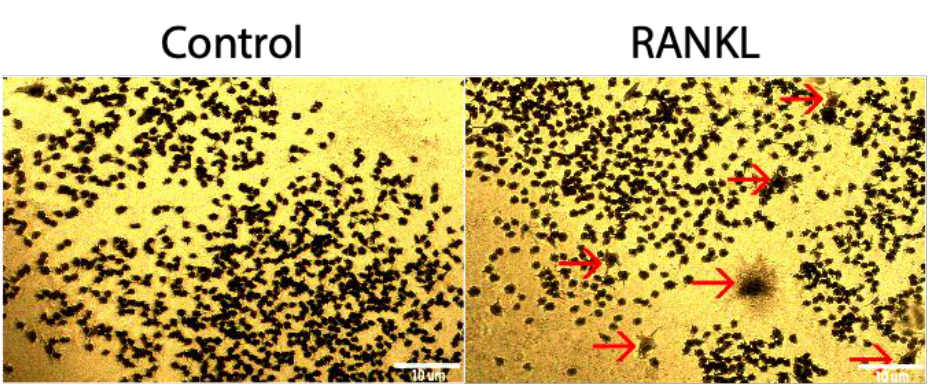
Figure 3. TRAP assay of RAW264.7 cells stimulated with RANKL. After 5 days of treatment with 10 ng/mL of RANKL, 2.5% of stimulated cells stained positive for TRAP, whereas 0.09% of control cells not treated with RANKL stained positive for TRAP. Red arrows designate a TRAP positive cell. Images were acquired with a 10× objective lens and scale bars are set to 10 μm. All of the experiments were conducted in triplicate.